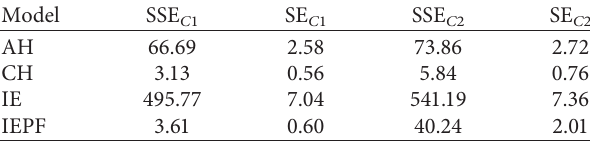
Table 16: Pullout test results from example 4.